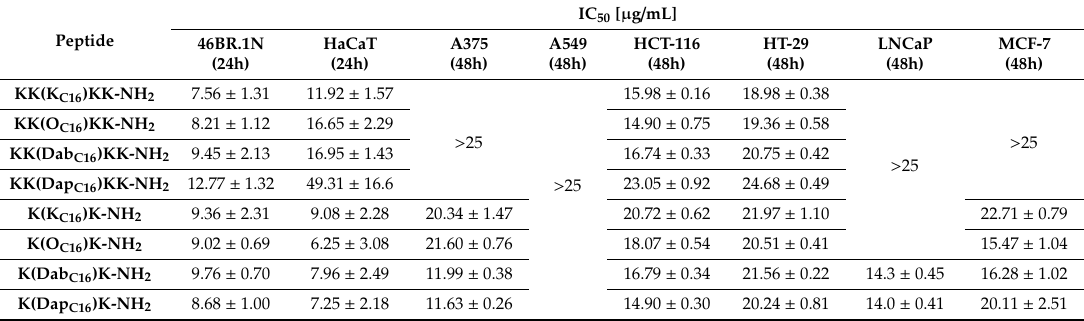
Figure 2. Hemolytic activity of double-headed lipopeptides. Table 2. Concentration of double-headed lipopeptides which caused 50% inhibition of normal and cancer human cell growth in vitro.